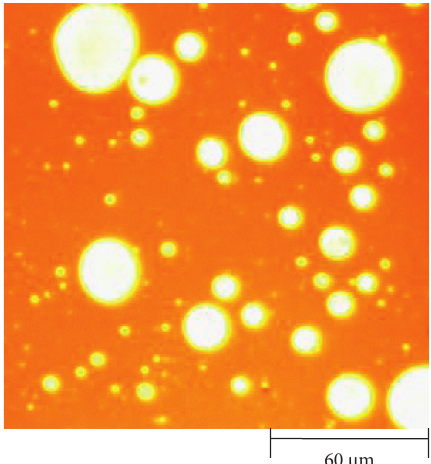
Figure 4: Fluorescence micrographs of undeveloped SBS modified asphalt with 5% content of